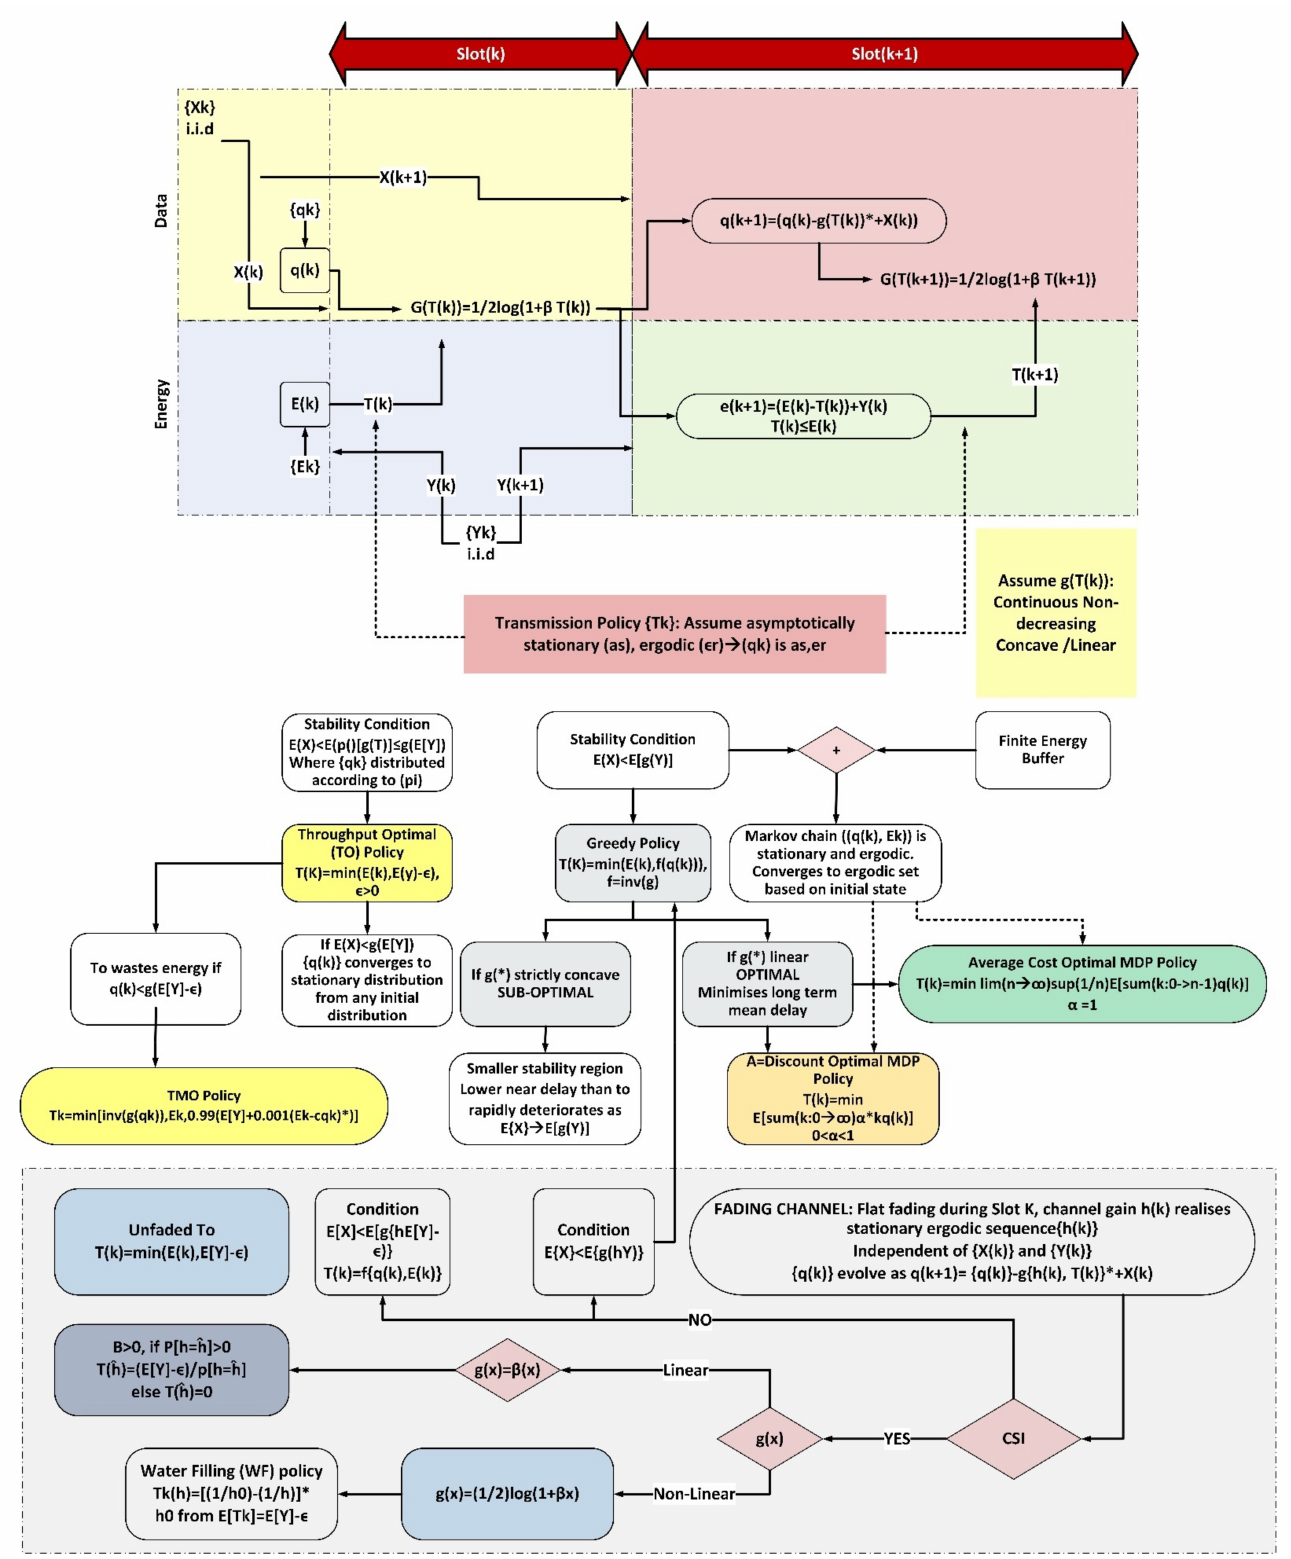
Figure 6. Schema of various MDP